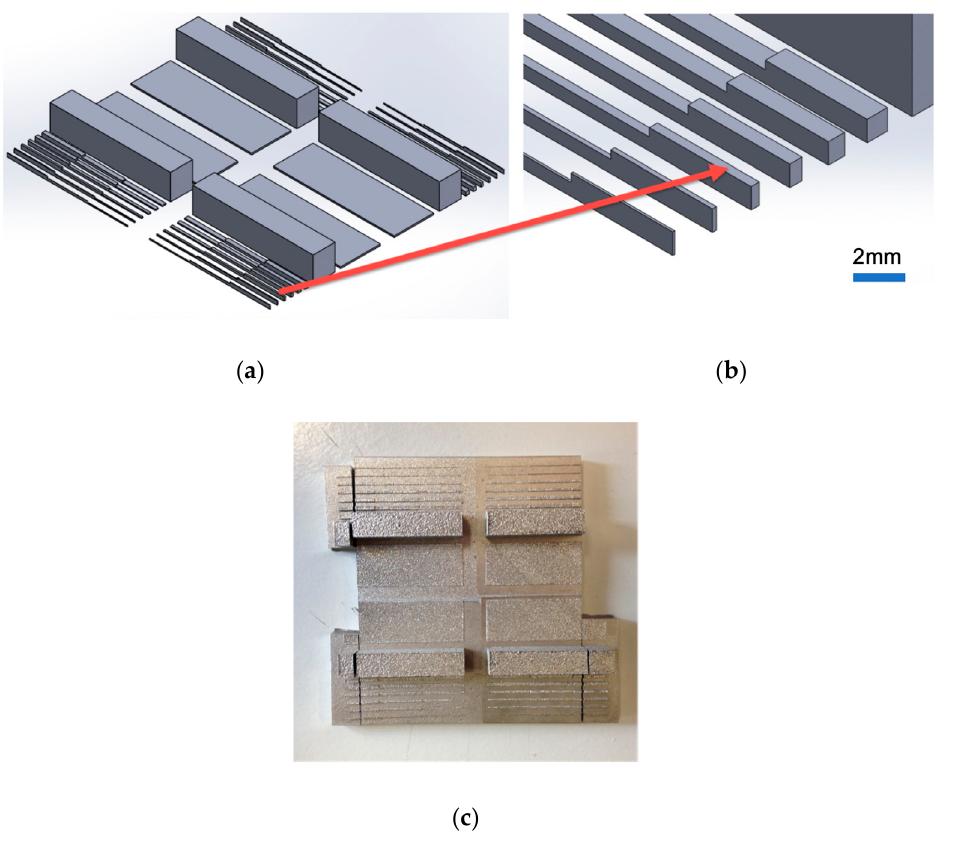
Figure 1. Testing patterns with large ridge and micro ridge arrays: ( a ) four identical testing patterns, ( b ) enlarged view of aspect ratio of rectangular ridges, ( c ) printed patterns on four roughness plates.